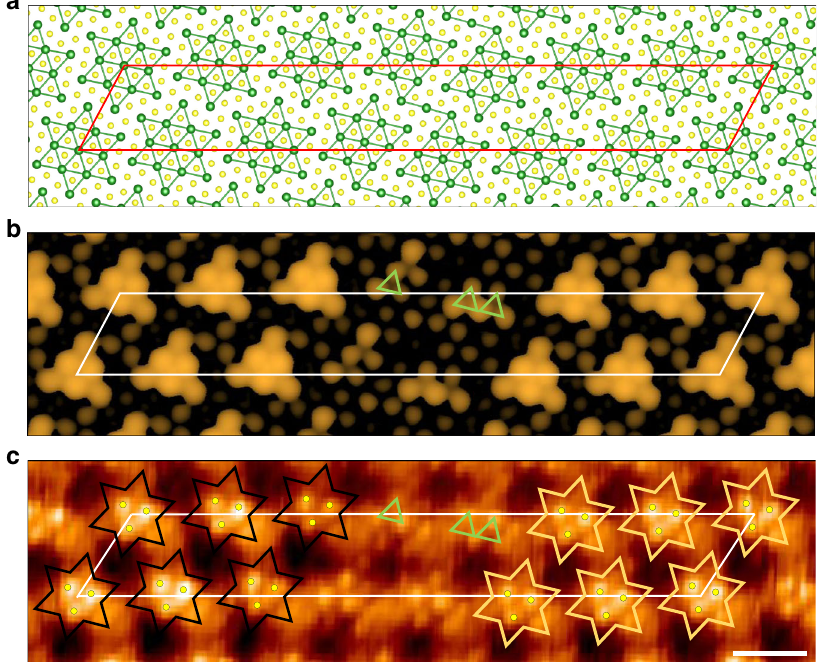
Fig. 2 Atomic structure and STM images of DW-1. a Atomic structure, b simulated STM image ( V = − 50 meV, ρ = 1 × 10 − 5 e Å − 3 , and c experimental STM image. The green triangles denote the triangular shape of protrusions in domain-wall area. Scale bar , 1 nm